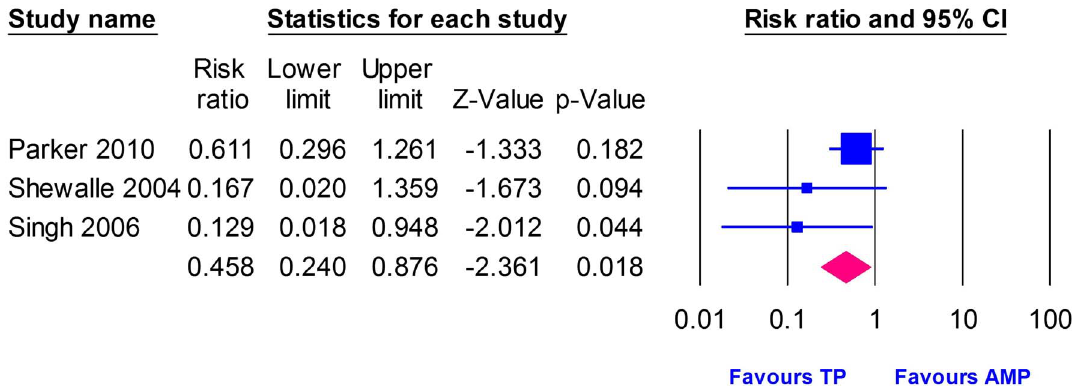
Figure 5. Forest plot of risk ratio (RR) of reoperation and revision rate with 95% con fi dence interval, comparing Thompson and Austin Moore